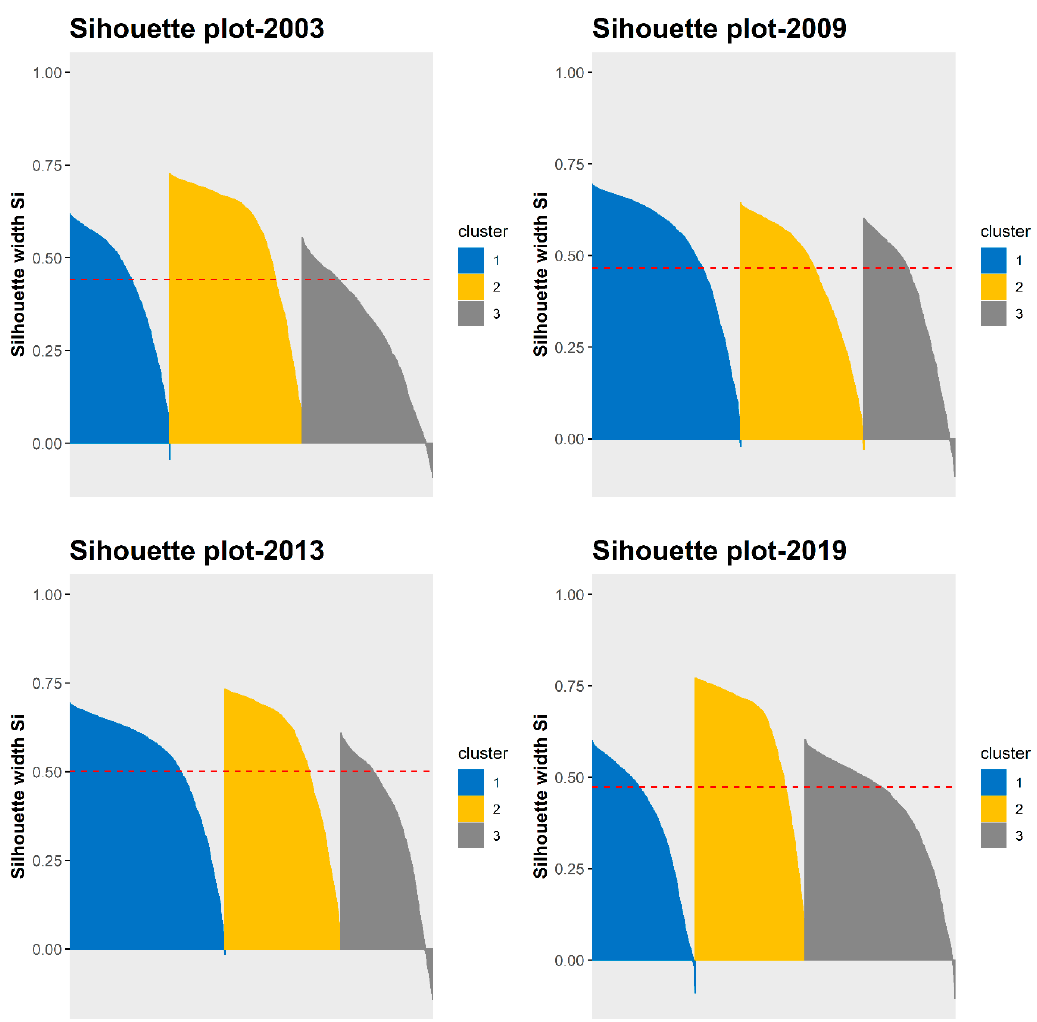
Figure 5. The silhouette plot of selected years. The average silhouette width (si) of the clusters (red dashed line) are all well above 0, and only a few grids have negative si (i.e., they are probably wrongly placed). The number of observations in each cluster is indicated by the cluster width.